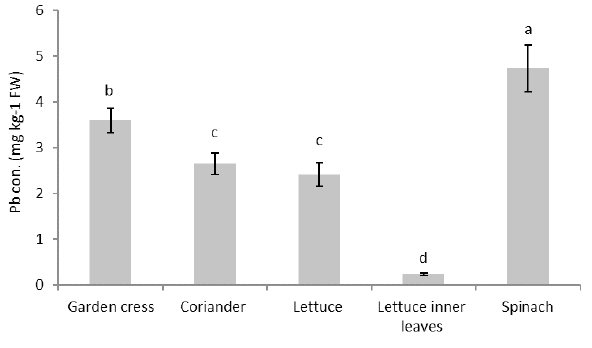
Figure 1: Cadmium concentration of foliages of different vegetable crops irrigated using wastewater. Bars represent averages of five replicates ± SD. Bars with same letter are not significantly different at 5% level of Duncan test